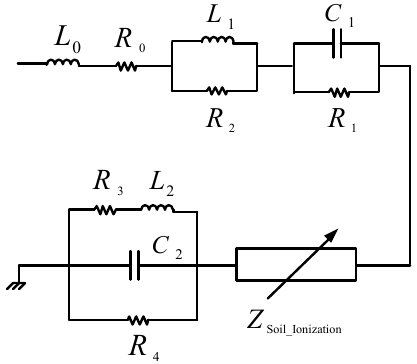
Figure 6. Conventional grounding system impedance model.